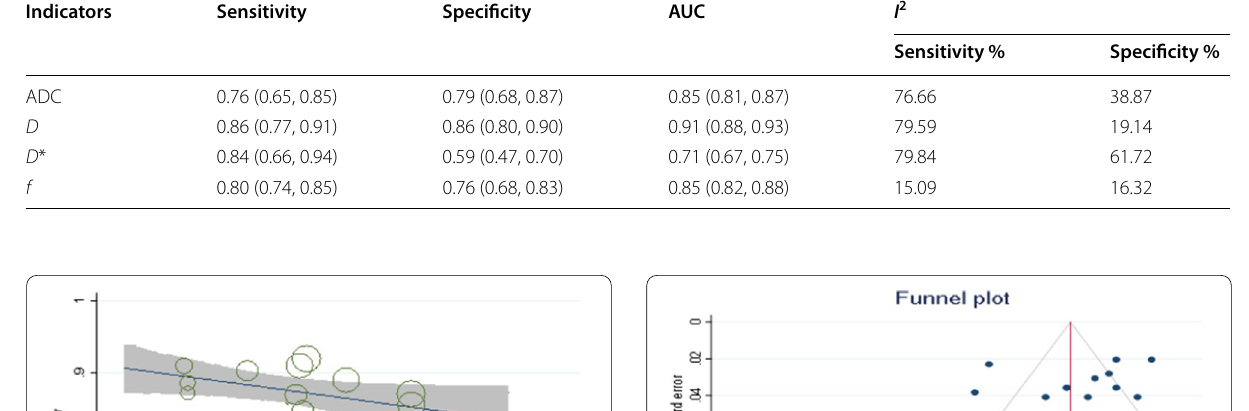
Table 4 The pooled estimation of sensitivity and specificity of breast lesions Indicators